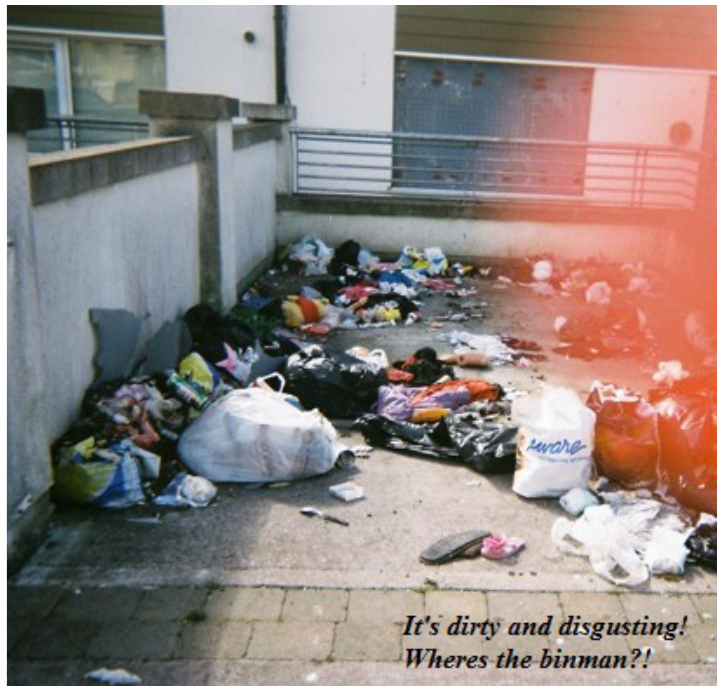
Figure 2. Photovoice: ‘It’s dirty and disgusting! Where’s the